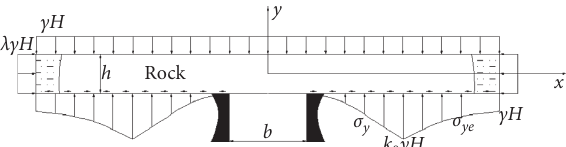
Figure 1: Mechanical model of thin immediate roof.